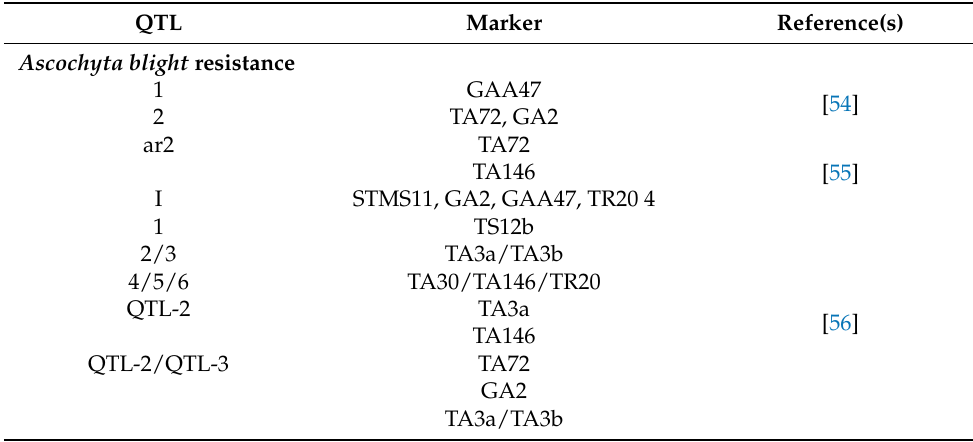
Table 2. QTLs generated for Ascochyta blight and Fusarium wilt